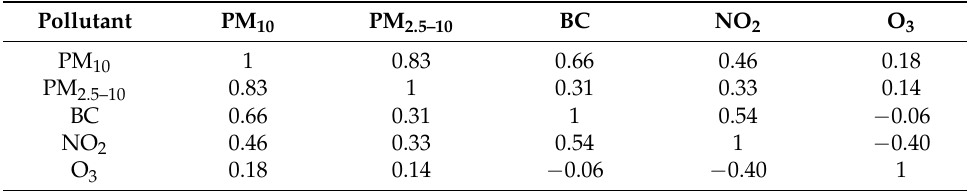
Table A4. Correlation matrix with R-values (Pearson correlation coefficients) between the different air pollutants measured in Stockholm during springtime (March, April and May) during the period from 2000 to